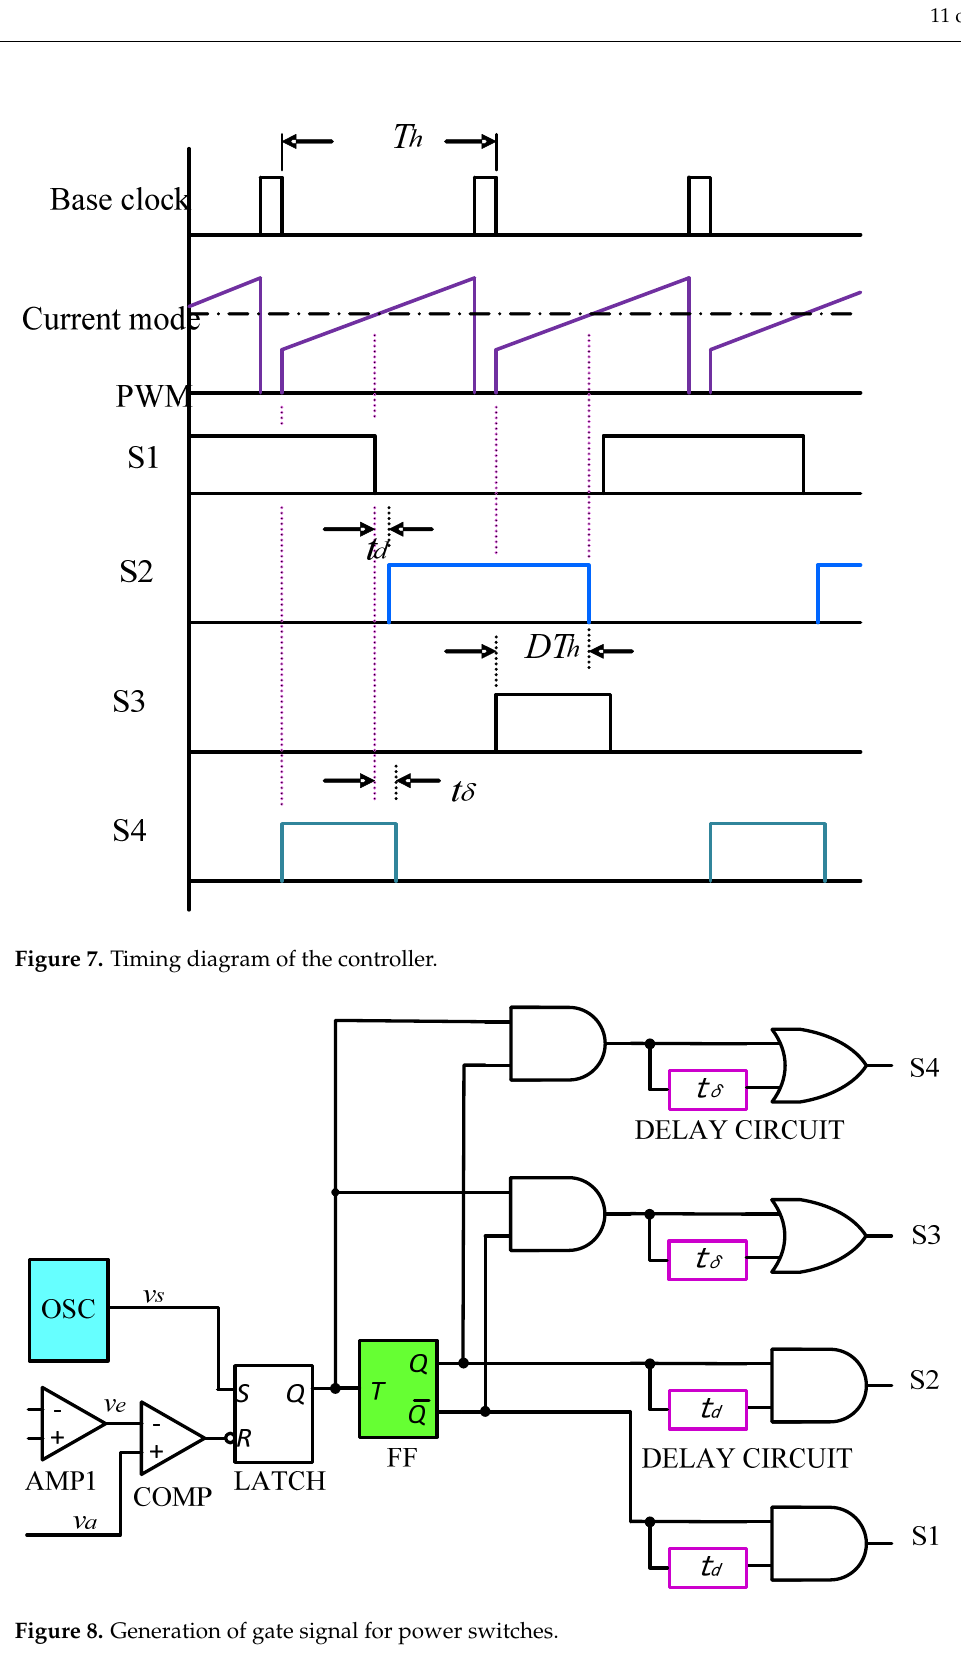
Figure 8. Generation of gate signal for power switches.